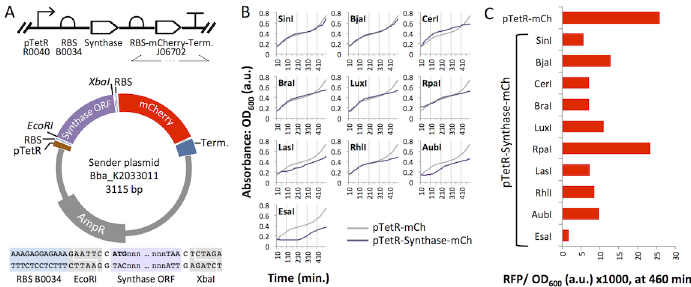
Fig 3. Sender plasmids expressed in Escherichiacoli BL21. (A) The modular Sender vector allows facile cloning of any EcoRI , XbaI -flankedsynthase open reading frame (ORF) and co-expression with mCherry (mCh) from a single bicistronic mRNA. The vector is represented as SBOL [44] glyphs (top) and a scaled circular map (bottom). (B) Optical density (OD) readings for E . coli cultures expressing each of the Sender plasmids. (C) mCherry expression is shown as end-point RFP signal normalized to OD 600 after an 8 hour growth